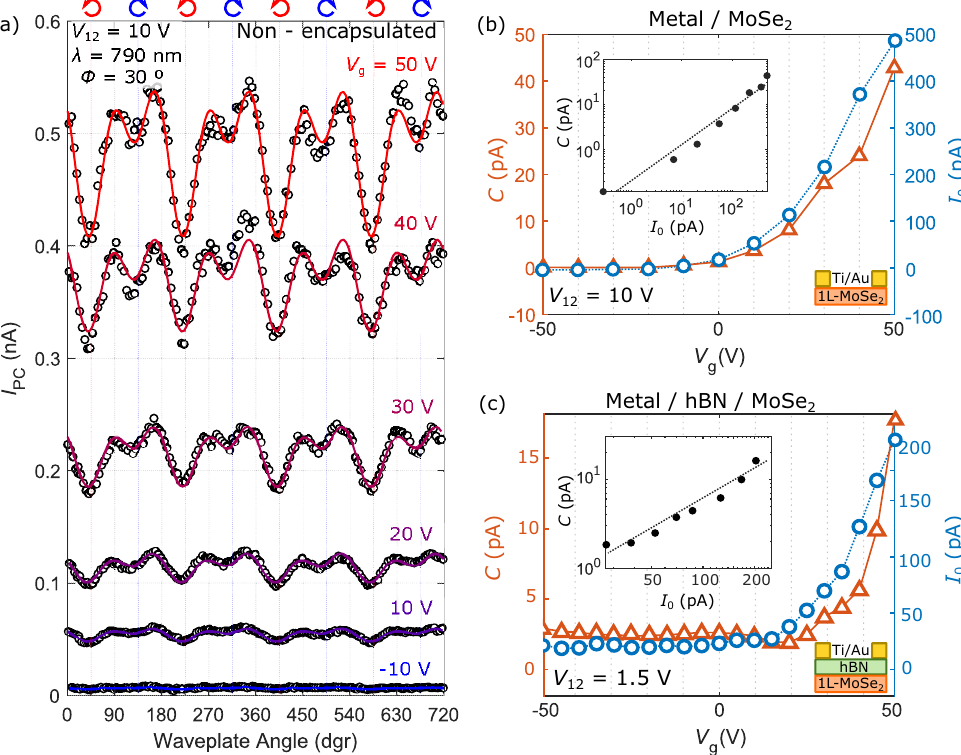
Fig. 3 Effect of the gate voltage on the helicity-dependent photocurrent. a Measured photocurrent I PC in the non-encapsulated device for different gate voltages V g , from − 10 V to 50 V, as a function of the λ /4 waveplate angle. The black solid lines are least-square fi ts of the experimental data to Eq. 1. b – c V g dependence of the I 0 (blue circles, right axis) and C (orange triangles, left axis) photocurrent components for the non-encapsulated ( b ) and hBN-encapsulated ( c ) devices. The insets in pannels b and c show C as a function of I 0 in logarithmic